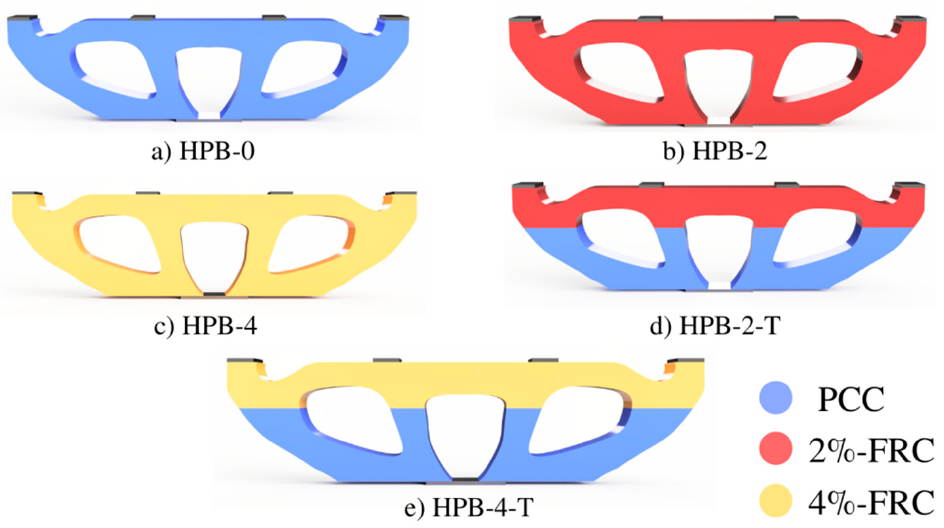
Figure 8. Fiber dosage layout in TOHPB ( a ) HPB-0 ( b ) HPB-2 ( c ) HPB-4 ( d ) HPB-2-T and ( e ) HPB-4-T.